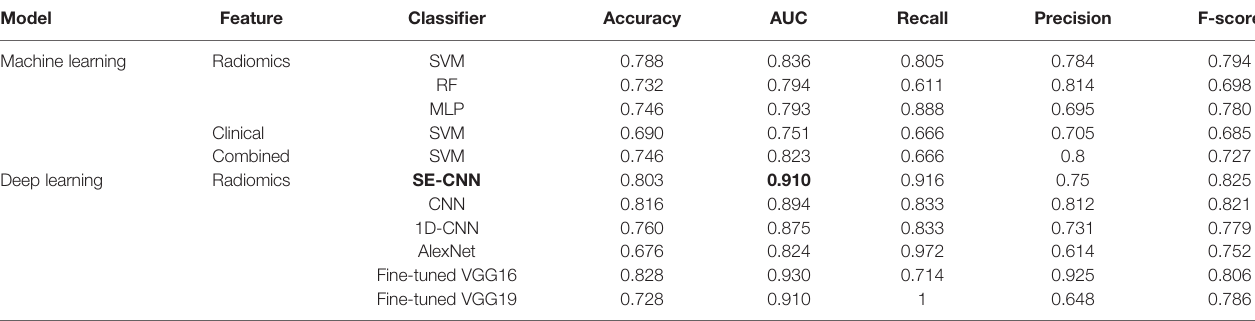
TABLE 2 | Predictive performance of machine learning models using radiomics features (SVM, RF, MLP), clinical features, and combined features, and the deep learning models (SE-CNN CNN, AlexNet, Fine-tuned VGG16, and Fine-tuned VGG19) for the internal test cohort of 71 patients.